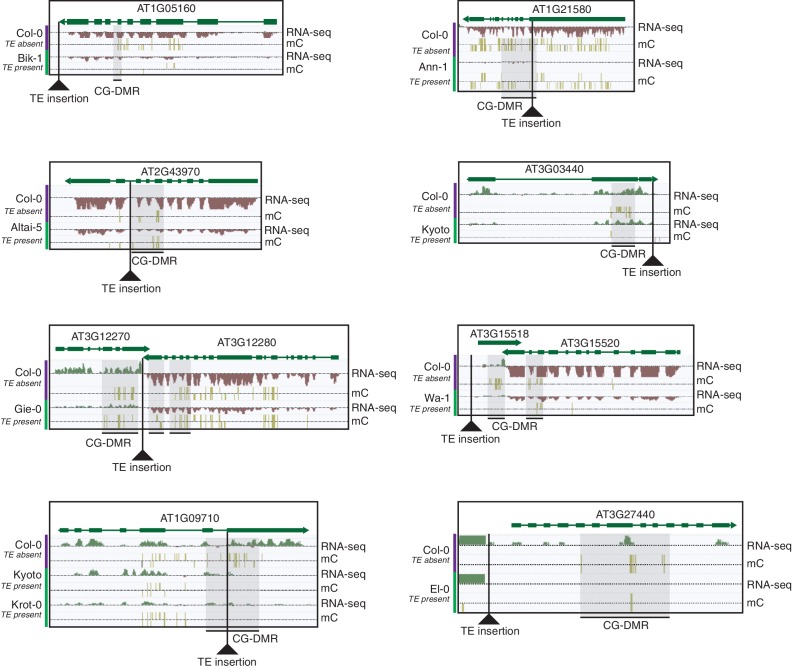
Selected examples of TE insertions apparently associated with transcriptional downregulation of nearby genes and loss of gene body CG methylation leading to the formation of a CG-DMR.